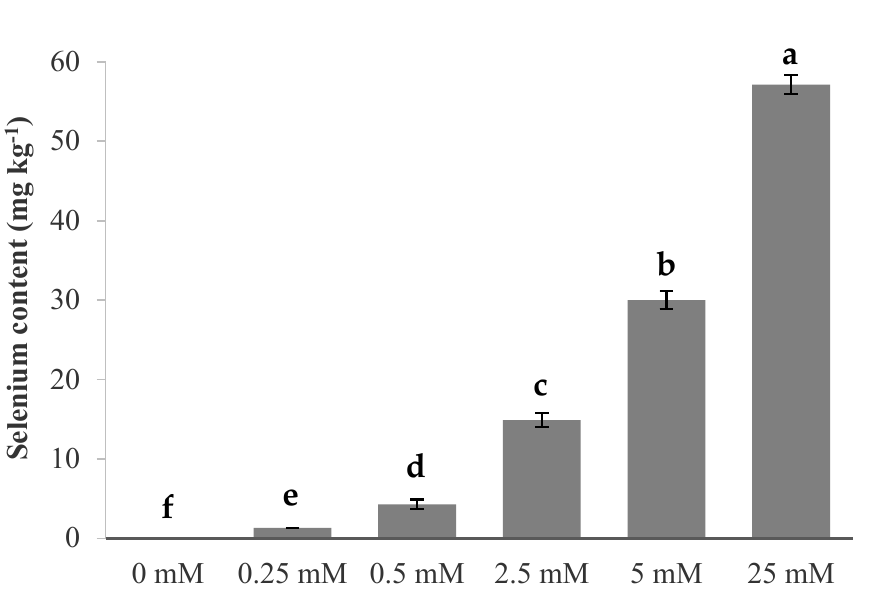
Figure 3. Selenium contents presented in seeds after 12 h of soaking with 0, 0.25, 0.5, 2.5, 5 and 25 mM of Na 2 SeO 4 . Values are means ± standard errors ( n = 5). Different letters demonstrate significant differences ( p < 0.05).